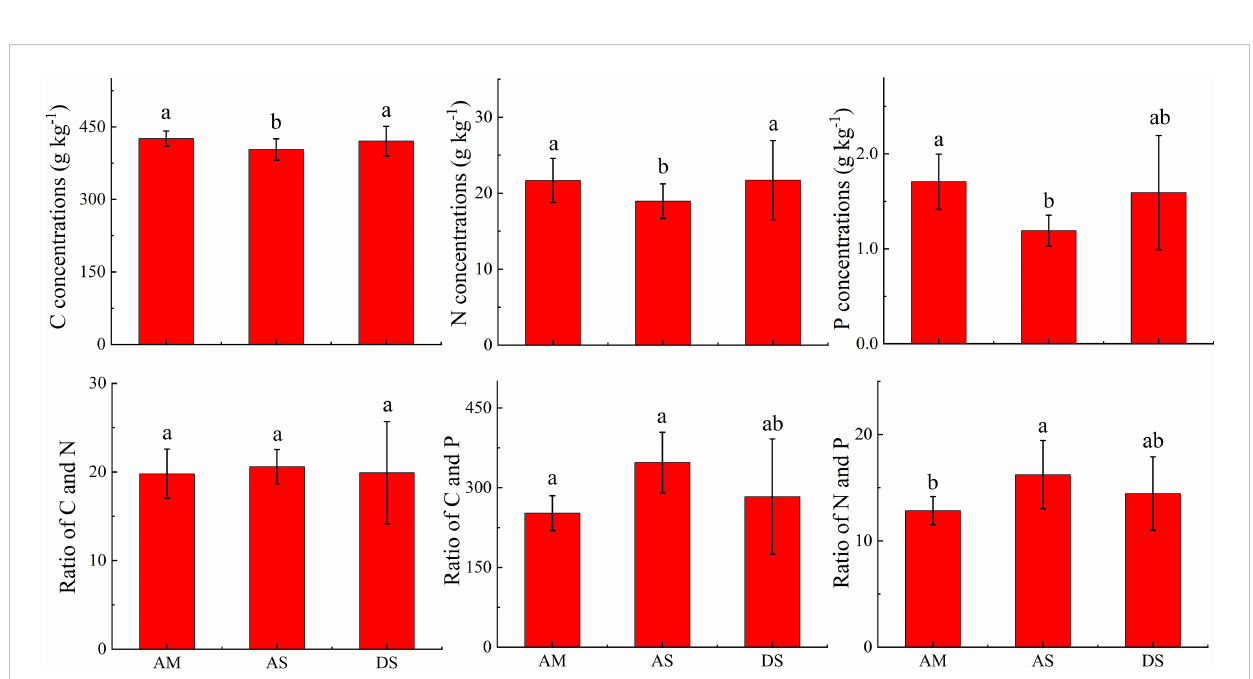
FIGURE 3 Comparison of foliar C, N, and P stoichiometry in different grassland types. Different letters above the column means the differences was signi fi cant at 0.05 level.